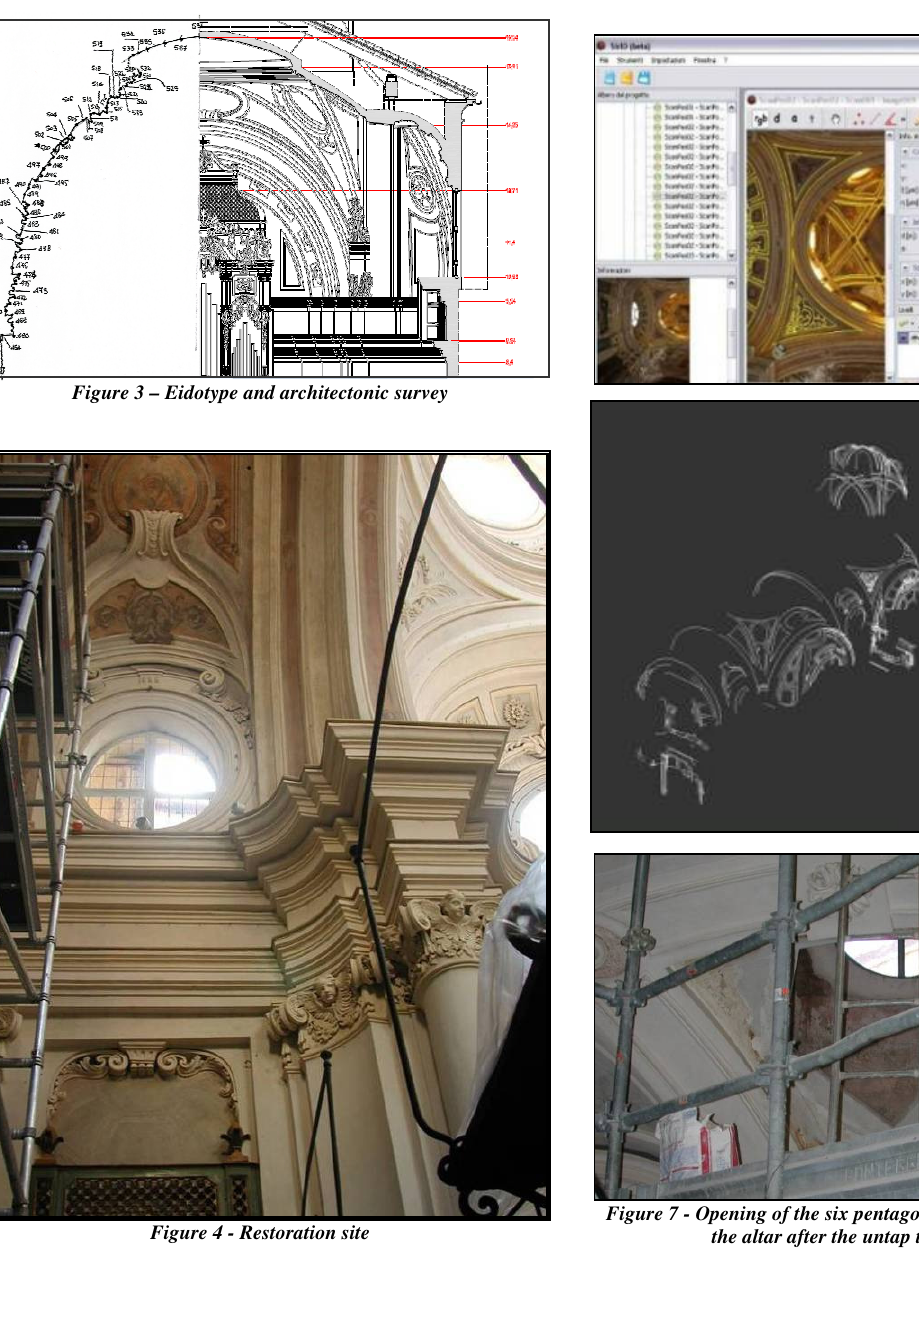
Figure 4 - Restoration site